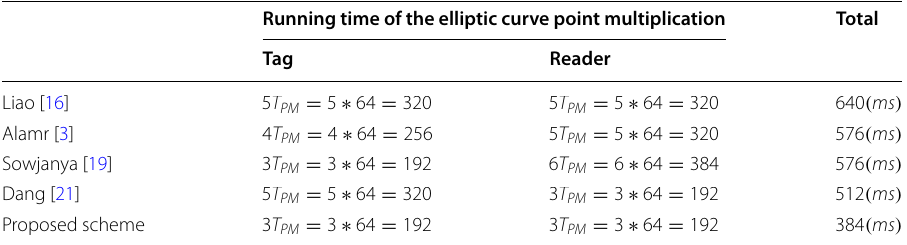
Table 9 The running time of the elliptic curve point multiplication among related protocols in authentication phase